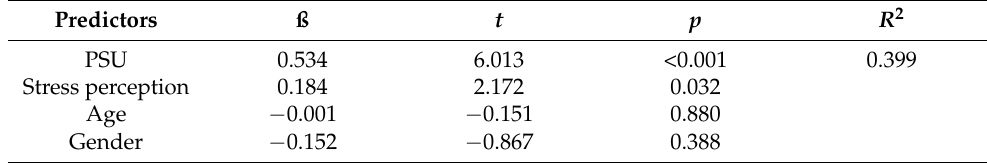
Table 5. Predictors of “Self-assessed problem of smartphone usage behavior” ( N =